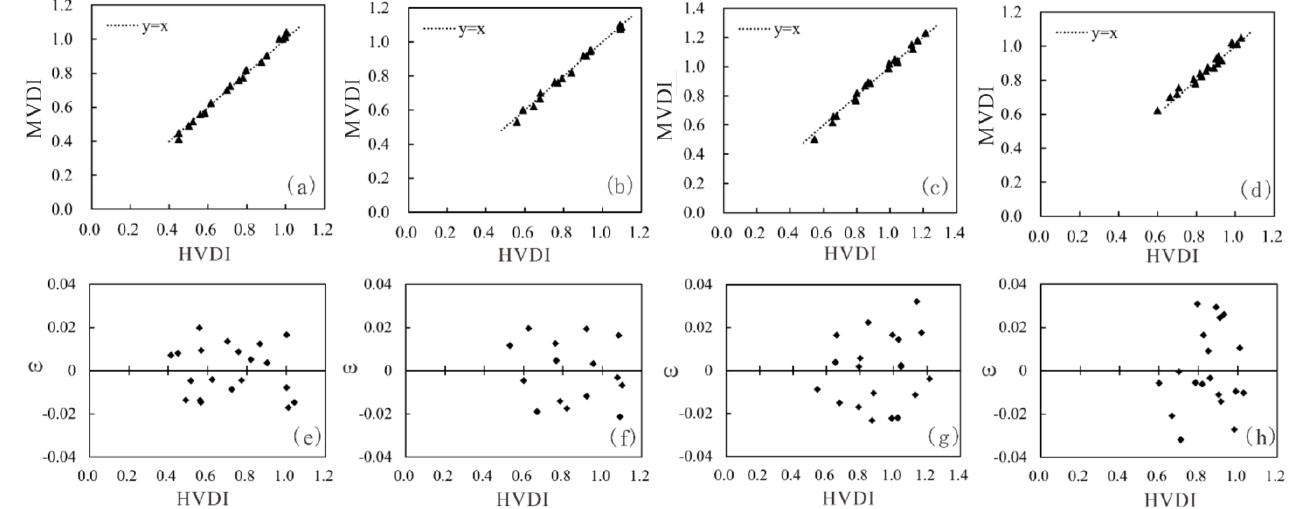
Figure 12. Comparison and residual analysis of the HVDI and MVDI. ( a – d ) The comparison between the HVDI and MVDI in the early, middle, late, and mature stages of crops; and ( e – h ) the residual analysis between the HVDI and MVDI in the early, middle, late and mature stages of crops.